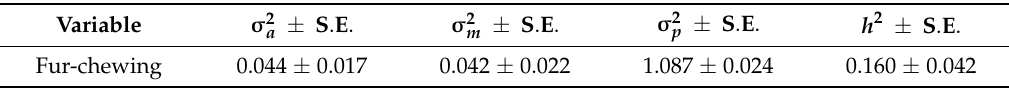
Table 2. Analysis of variance (ANOVA) of fur-chewing, animal sex and year of slaughter, over fur price in chinchillas. SV 1 SS 2 DF 3 MS 4 F 5 p -Value Model. 47,825.9 3 15,941.9 72.9 <0.0001 Fur-chewing 36,973.2 1 36,973.2 169.0 <0.0001 Sex 3351.2 1 3351.2 15.3 0.0001 Year 7501.5 1 7501.5 34.3 <0.0001 Error 656,702.5 3003 218.7 Total 704,528.4